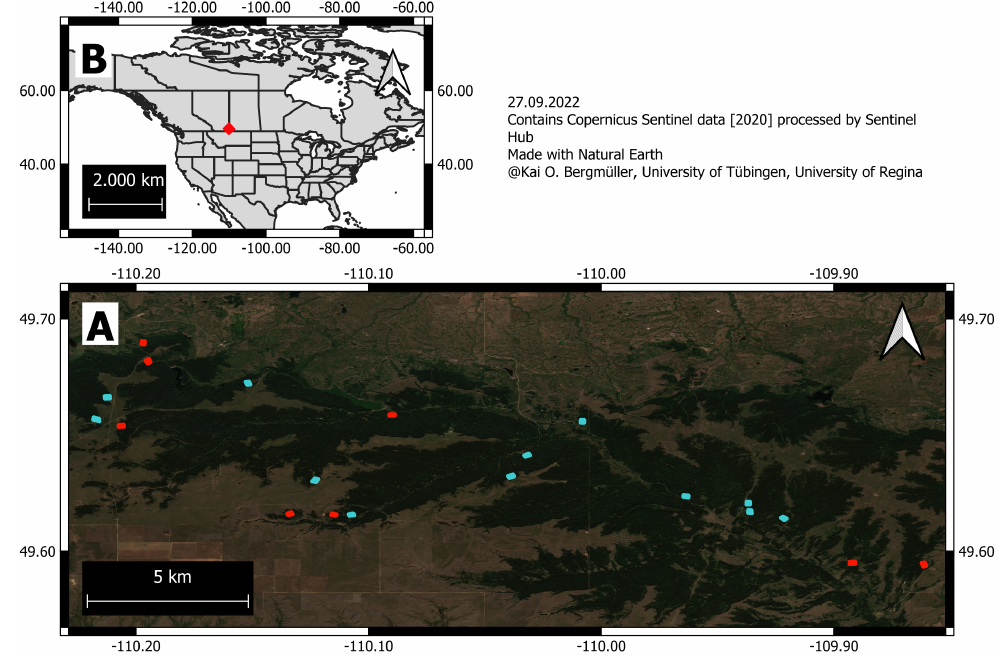
Figure 1. ( A ) Location of 20 forest stands within Cypress Hill Interprovincial Park, coloured based on whether they were sampled for soil moisture (blue) or not (red). ( B ) Study area location within North America.